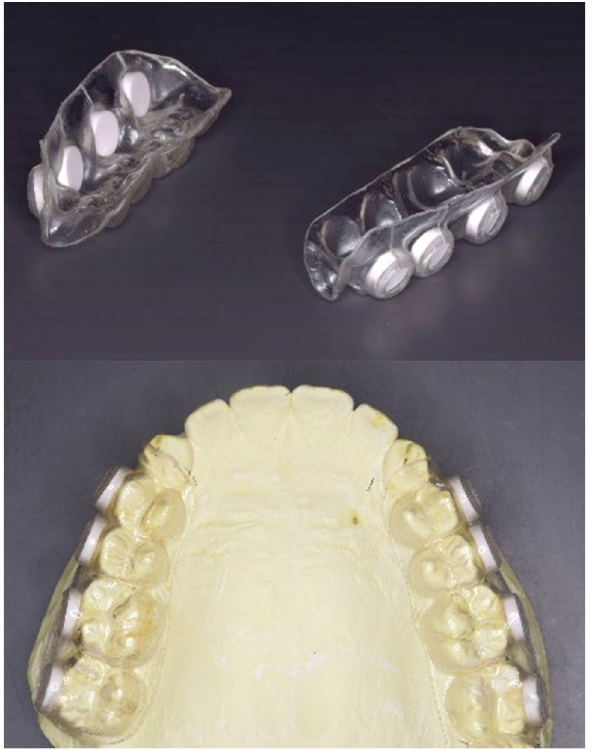
Figure 1. In situ dental biofilm model. Schematic of the in situ dental biofilm model. Oral appliances with HA disks inserted into the buccal sides were used to observe the formation of experimental